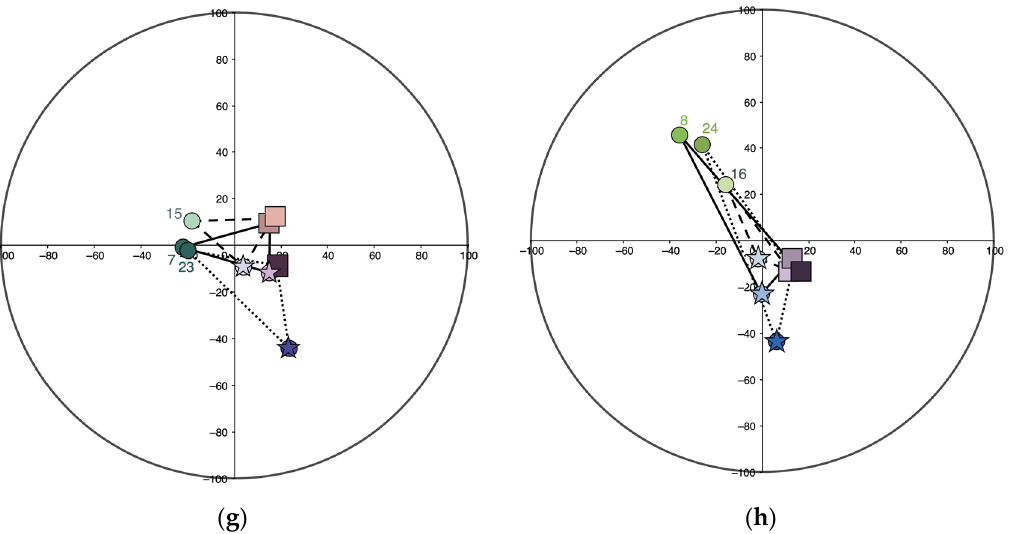
Figure 15. Hue (h°) and chroma (C) of the main (circle), background (square), and “intermediary” (star) colors in Sections I (unbroken line), II (dash line), and III (dotted line); projection into the CIELCh color circle: ( a ) Charts 1, 9, and 17; ( b ) Charts 2, 10, and 18; ( c ) Charts 3, 11, and 19; ( d ) Charts 4, 12, and 20; ( e ) Charts 5, 13, and 21; ( f ) Charts 6, 14, and 22; ( g ) Charts 7, 15, and 23; ( h ) Charts 8, 16, and